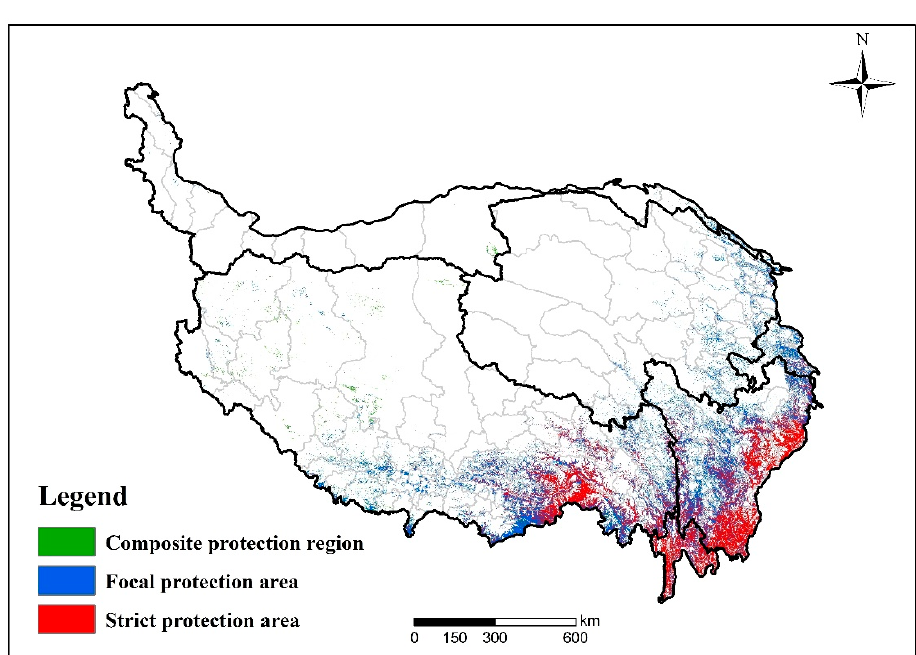
Figure 10. Spatial division of forest ecosystem optimization.